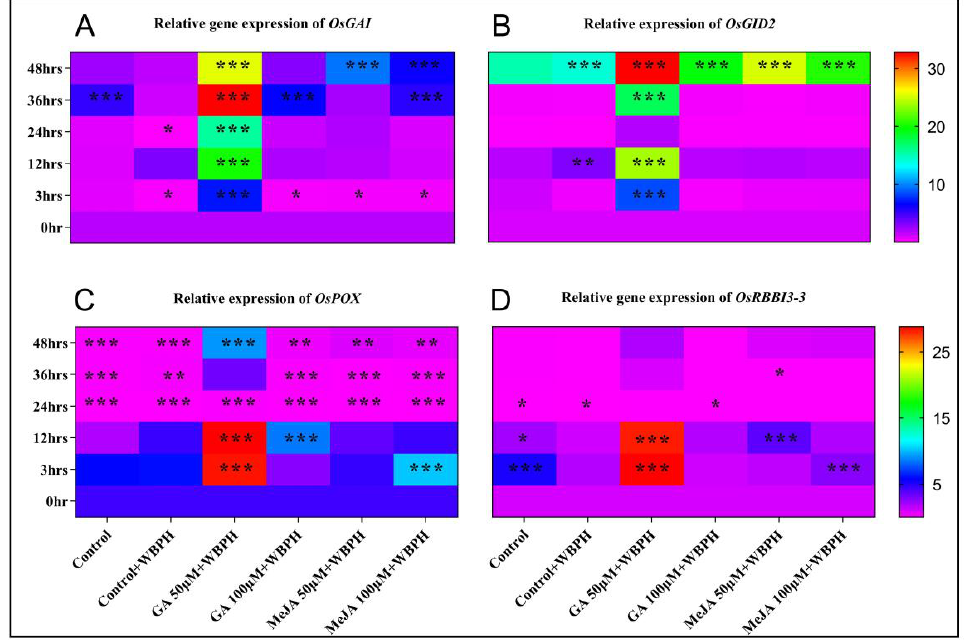
Figure 2. Relative gene expression of related genes in the plants in different treatment groups. ( A ) OsGAI . ( B ) OsGID2 . ( C ) OsPOX . ( D ) OsRBBI3-3 . The relative expression of each gene was measured after 0, 6, 12, 24, 36, and 48 h of WBPH infestation and hormone treatment. The actin gene was used as the reference gene. Each result is the mean of three replicates. Error bars represent the standard error of the mean data ( n = 3). The error bars with no asterisks indicate non-significant differences, and asterisks indicate a significant difference (* p < 0.05, ** p < 0.01, *** p < 0.001), according to analysis using two-way ANOVA and the Bonferroni post hoc test. The experiments were repeated three